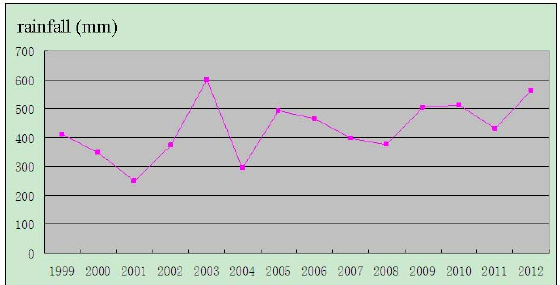
Figure 6. Rainfall of Qiqihar City from 1999 to 2012